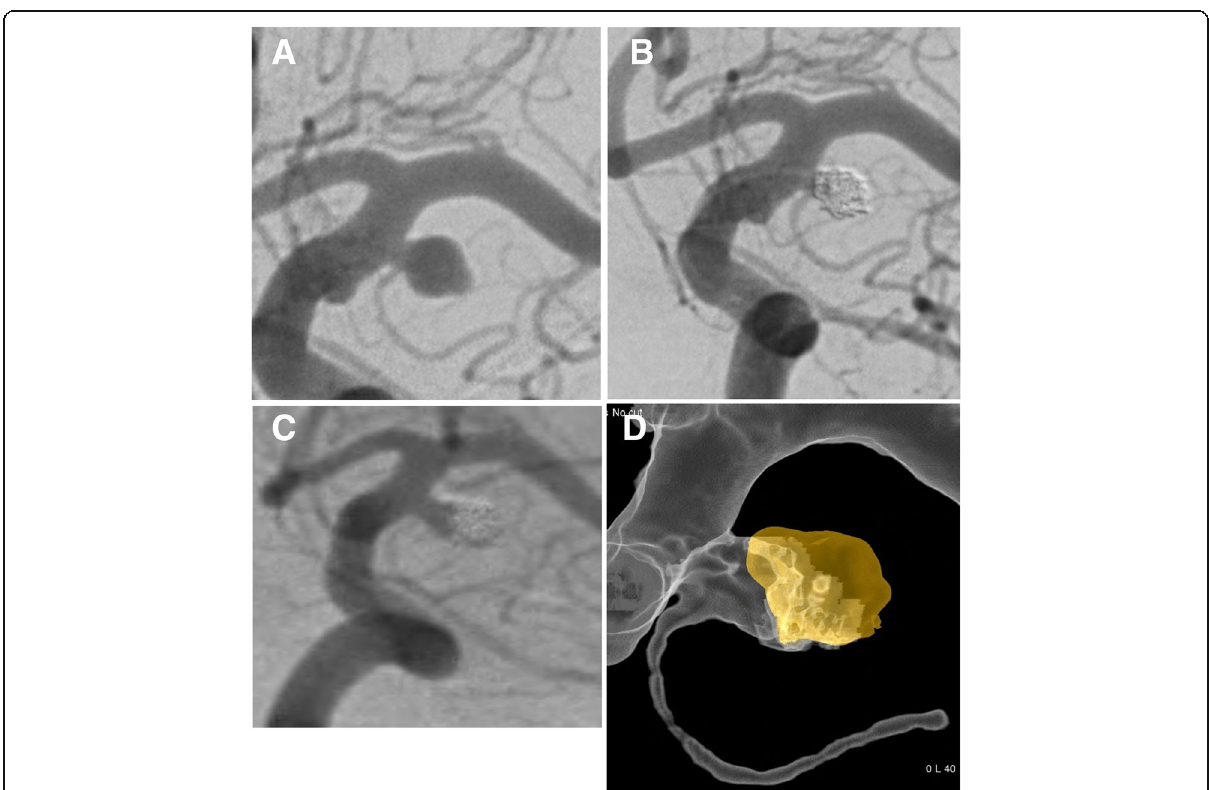
Fig. 2 PCOM aneurysm. a DSA: the PCOM is seen originating from the neck of the aneurysm. b DSA showing successful coiling of the aneurysmal sac sparing the PCOM artery. c Follow-up DSA 6 months later shows partial recanalization along the neck of the aneurysm. d Dual 3D conventional angiography clearly depicts the recanalization along the aneurysm neck with patent PCOM